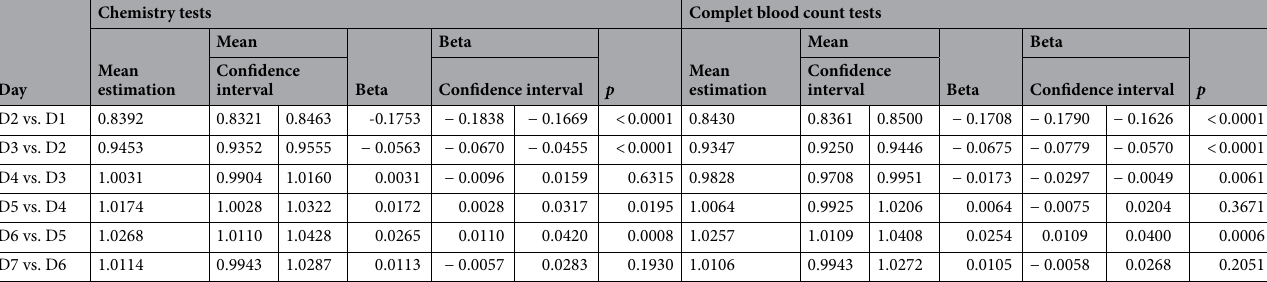
Table 3. Daily variations in the number of chemistry and complete blood count tests performed per